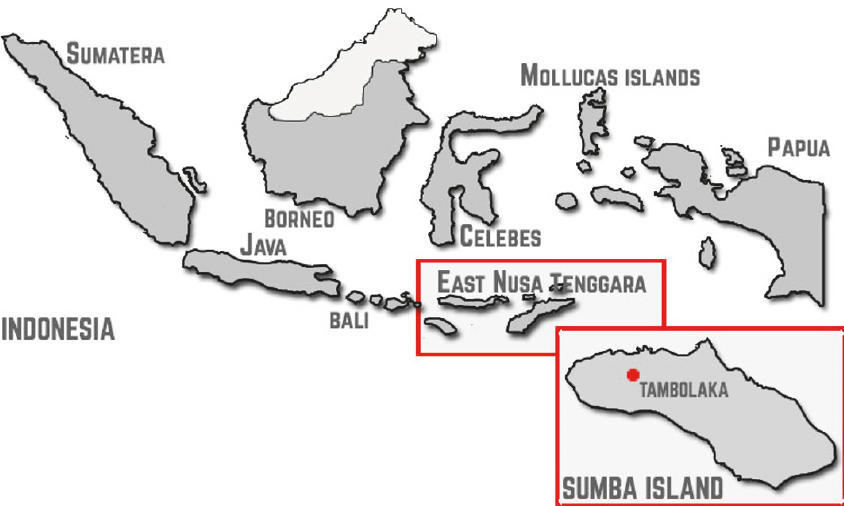
Figure 1: Geographical map of study location. Tambolaka is the capital of SSD, Indonesia, and Perobatang Village is a 2-hour drive from the